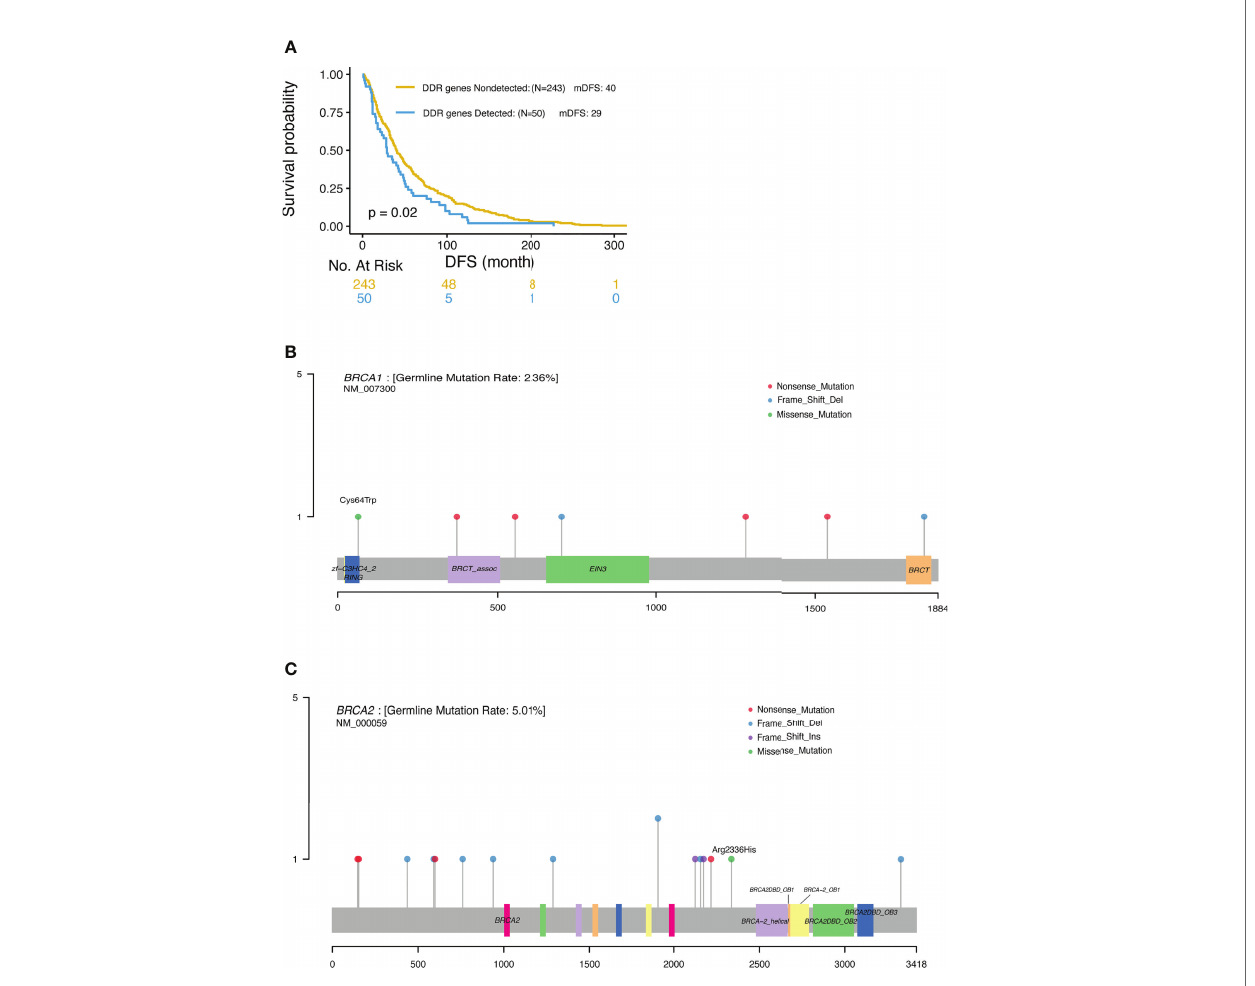
FIGURE 5 | (A) Signi fi cantly different outcome associated with DDR gene mutations for DFS. (B) Locations of deleterious BRCA1 mutations. (C) Locations of deleterious BRCA2